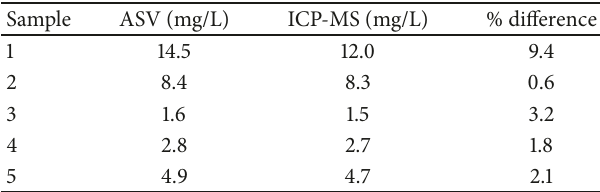
Table 2: Total Ba concentrations determined in 5 brake pad dust samples, taken from wheel rims, brake calipers, and pads from cars at a local mechanic’s garage. The F value is